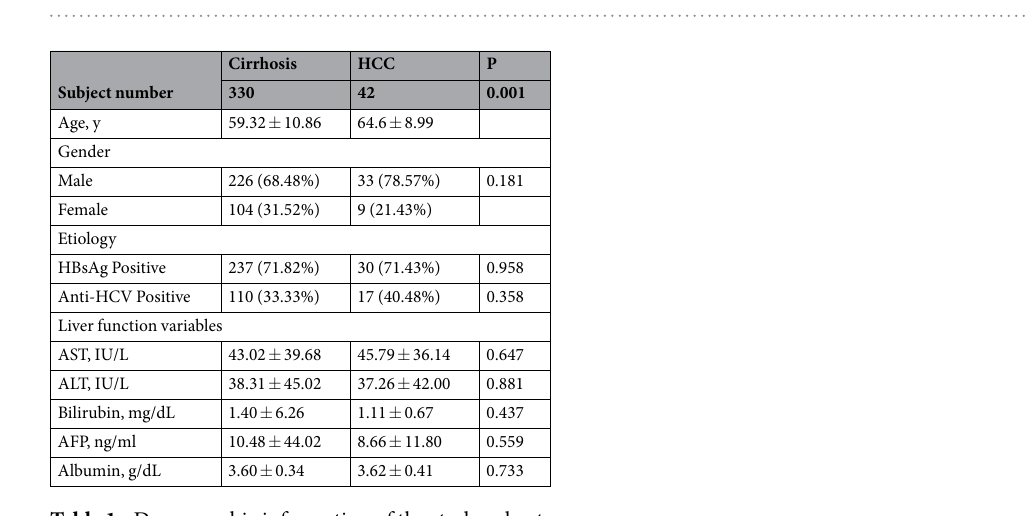
Figure 1. A flowchart of patient stratifications in this study.